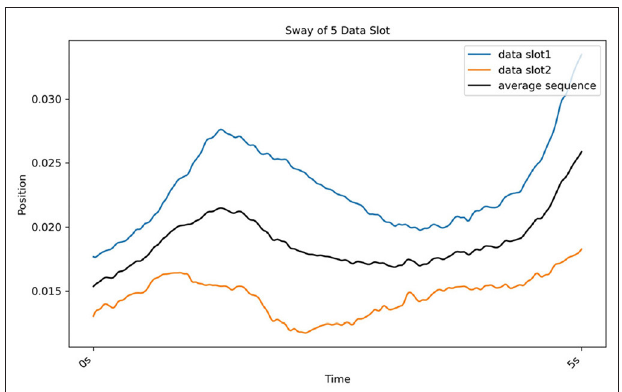
TABLE 2 | DTW-PAM result.